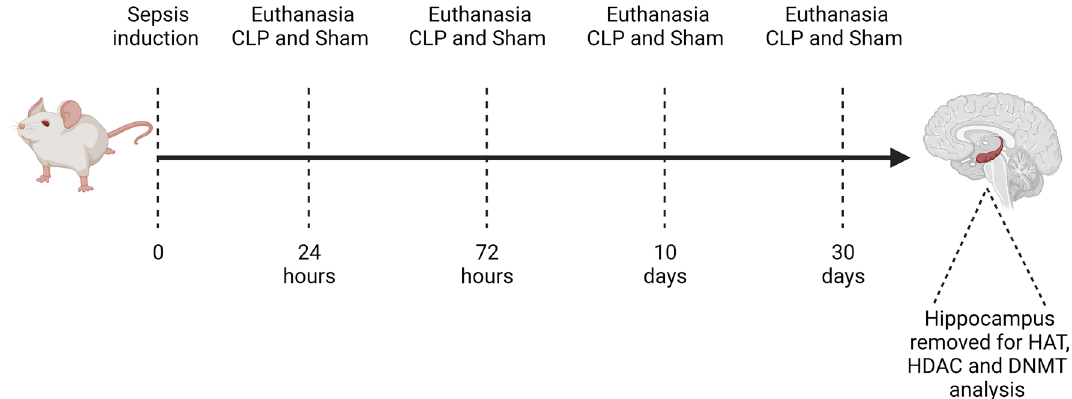
Figure 2. Timeline of the first experiment, dates of sepsis induction, animal euthanasia and structure removed for analysis.